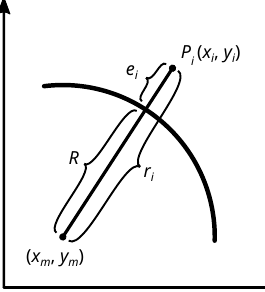
Figure 5. The orthogonal distances e i are defined as the residuals between the radii r i of the points P i and the circle radius R